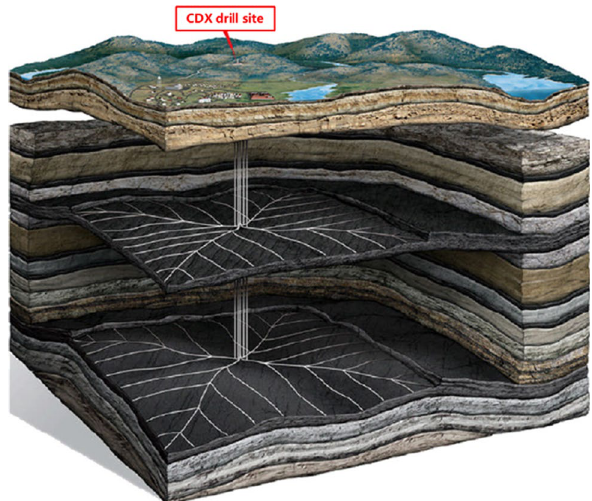
Fig. 12 Pinnate pattern of multilateral wells by CDX (Palmer 2010)